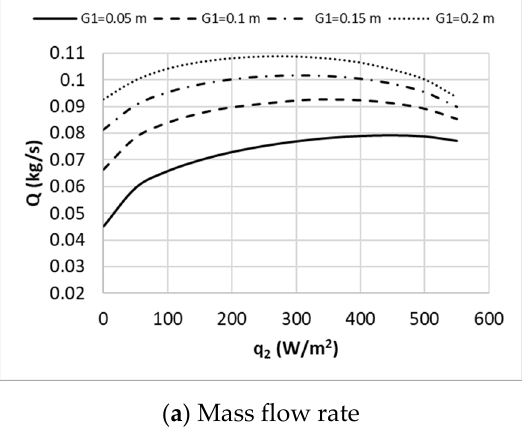
= 0.1 m) at different values of q 2 2 and G 1